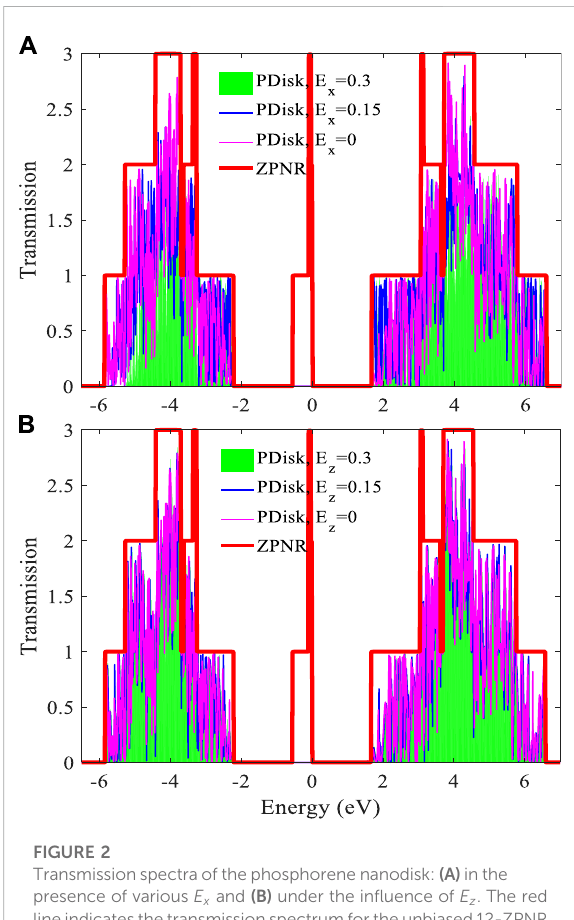
FIGURE 2 Transmissionspectraofthephosphorene nanodisk: (A) inthe presence of various E x and (B) under the in fl uence of E z . The red lineindicatesthetransmissionspectrumfortheunbiased12-ZPNR leads. The unit of the electric fi eld is